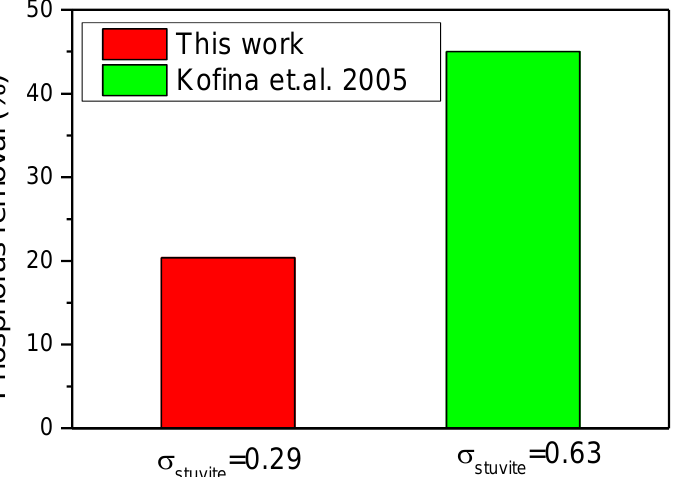
Figure 16. Phosphorus removal (%) from SWW supersaturated with respect to struvite; ( ◼ )inocu- lated with brucite obtained from hydrothermal treatment of MgO, ( ◼ )MgSO 4 as magnesium source [30].